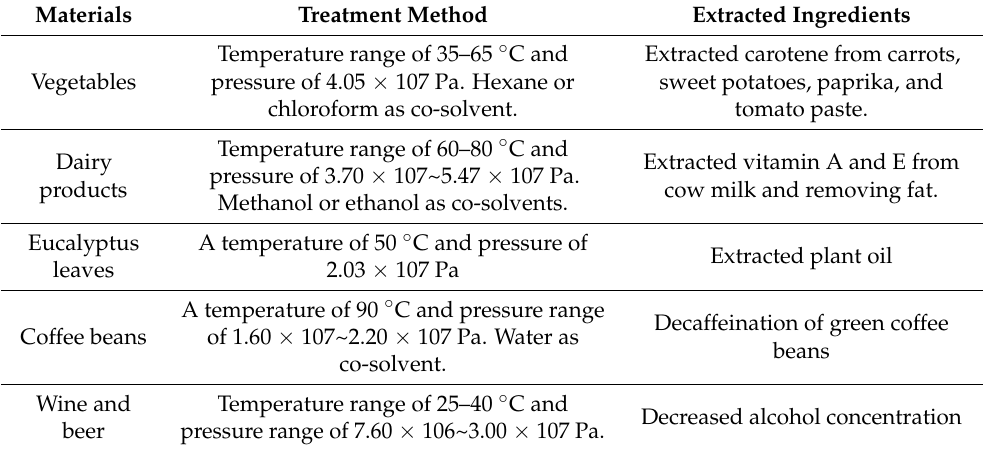
Table 1. Food materials commonly treated using supercritical extraction